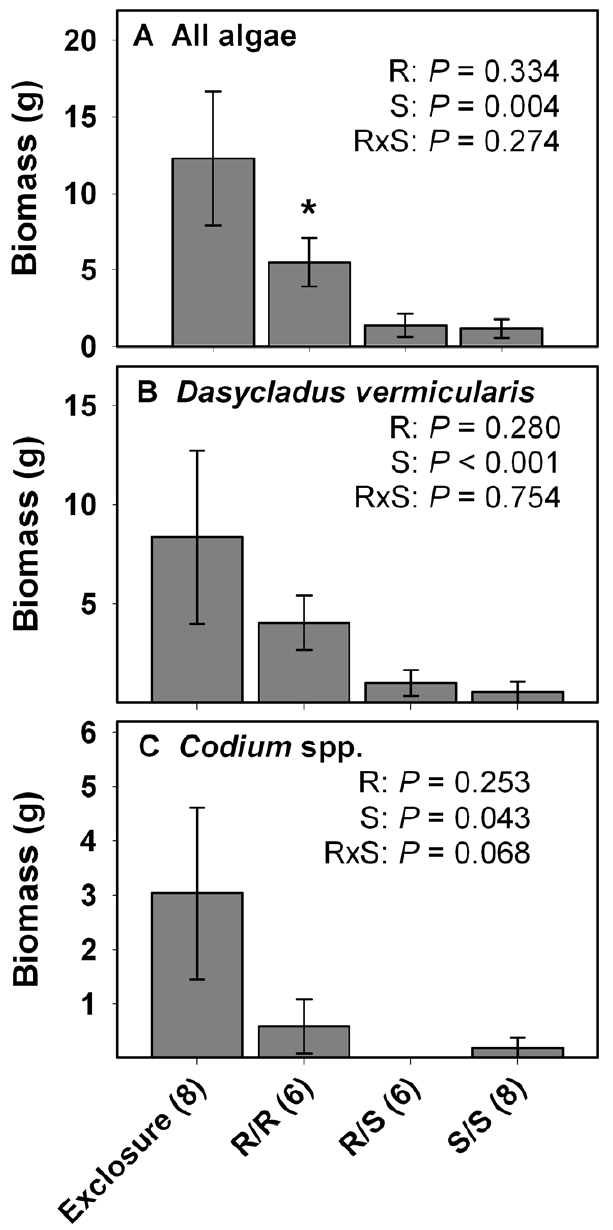
Figure 2. Biomass (mean 6 SE) of algae at the end of Year 1. Data are for (A) all algae, (B) Dasycladus vermicularis , and (C) Codium spp. Statistics are from two-factor ANOVA. * indicates that single- vs. mixed-herbivore treatments differ as determined via resampling statistics. Sample size is in parenthesis next to each treatment.